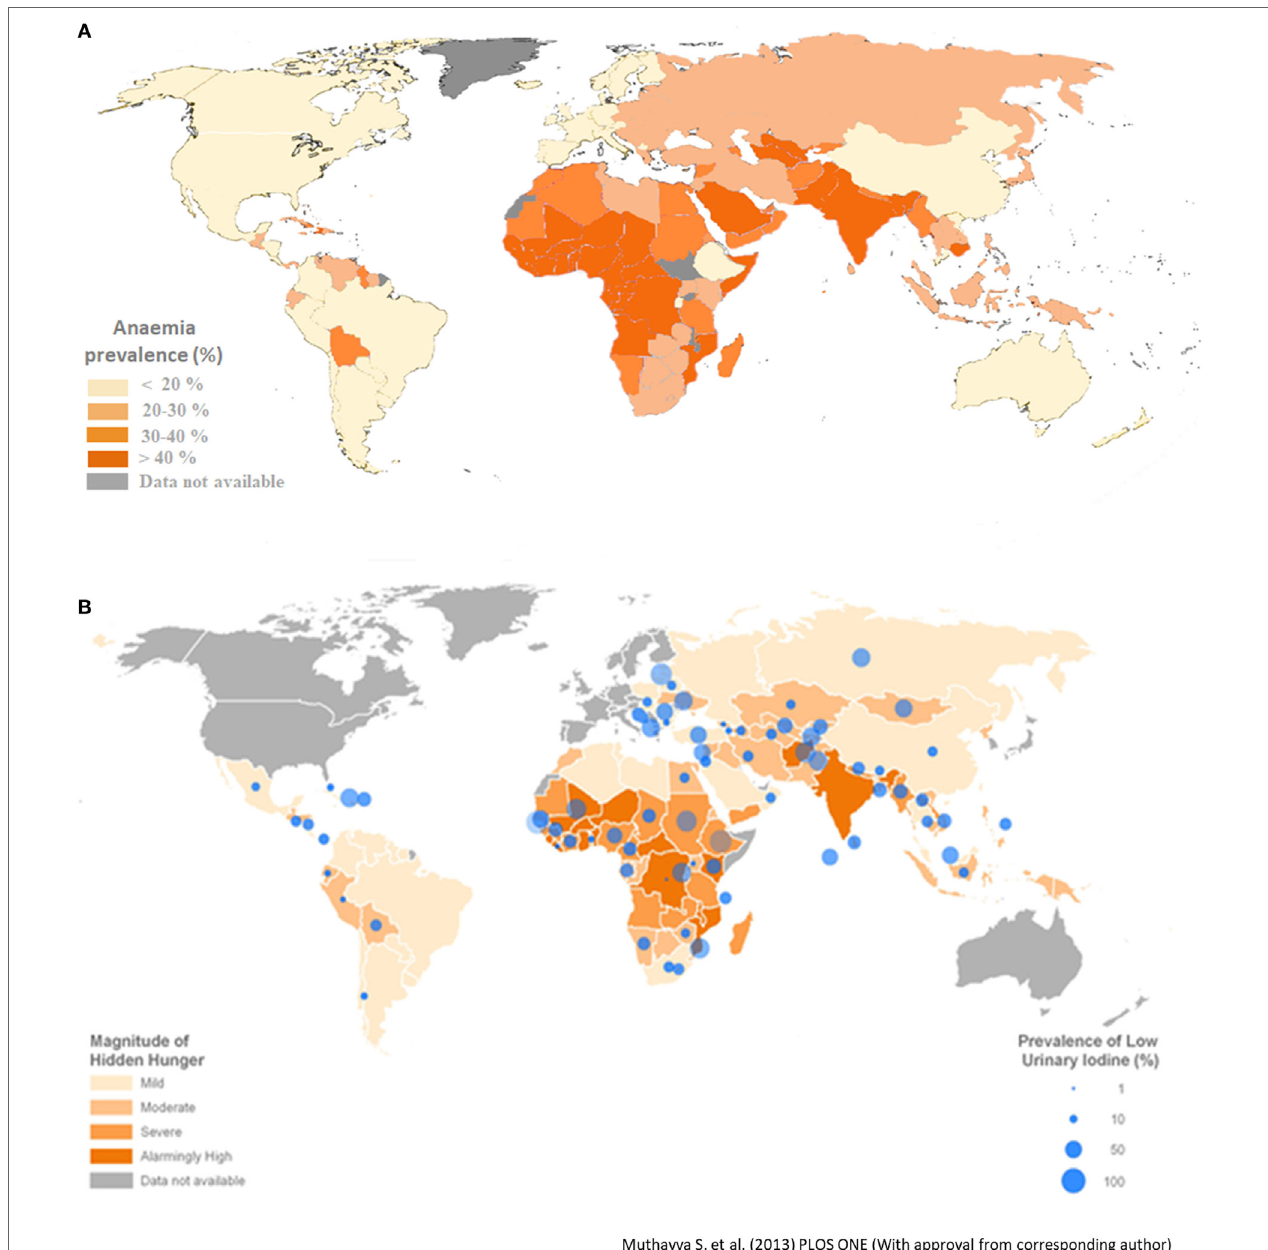
FiGURe 1 | (A) Prevalence of anemia in different parts of the world. Developing countries in Africa and Asia have high prevalence of anemia [Data from Stevens et al. (30)]. (B) Global map representing hidden hunger index and low urinary iodine concentration